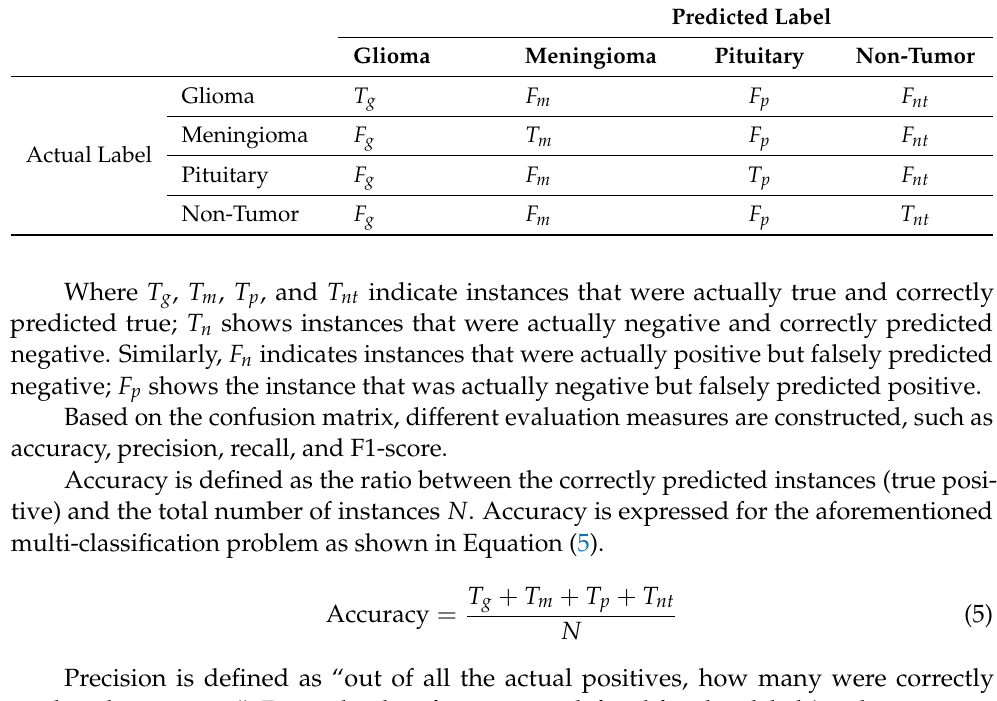
Table 3. Confusion